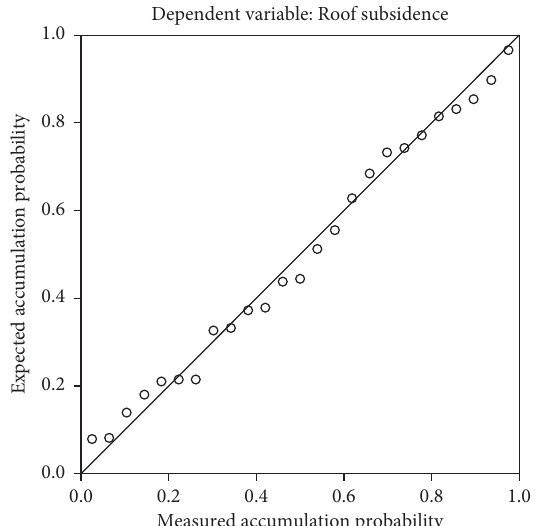
Table 12: Random error test of repeated mining under